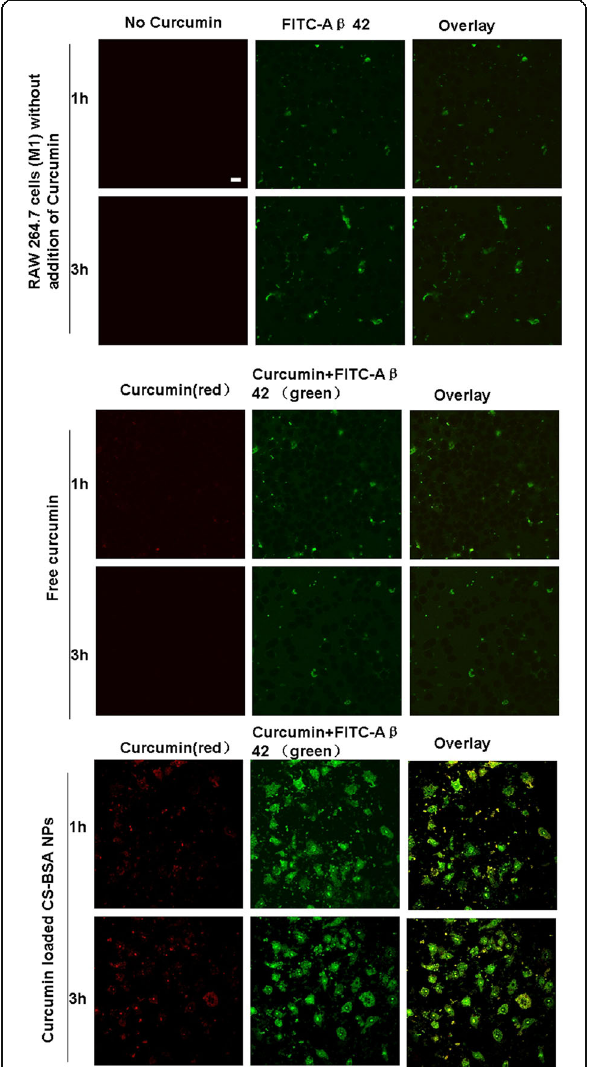
Fig. 5 Phagocytosis of A β 42 induced by free curcumin and curcumin loaded CS-BSA NPs. The scale bar is 50 μ m and applies to all figure